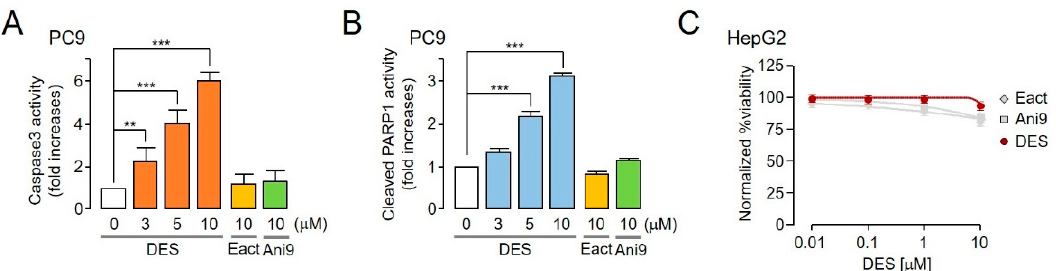
Figure 7. Apoptotic effect and hepatocytotoxicity of DES. ( A ) PC9 cells cultured with DES, Eact and Ani9 at the indicated concentrations for 24 h, with subsequent assessment of caspase-3 activity (mean ± S.D., n = 5). ( B ) The cells were cultured with the indicated concentrations of compounds for 24 h, and then cleaved PARP-1 activity was measured (mean ± S.D., n = 5). ( C ) DES concentration-dependent relative viability of HepG2 cells (red) was measured by quantifying resorufin derived from resazurin by intracellular reductases. Control experiments (Eact and Ani9) are marked for comparative analysis (gray) (mean ± S.D., n = 8). ** p < 0.01, *** p < 0.001.